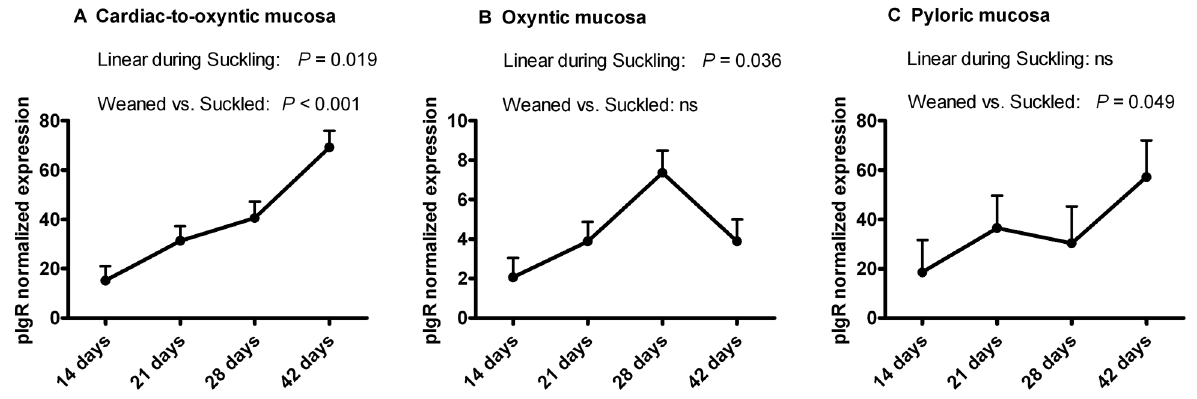
Figure 1. Polymeric immunoglobulin receptor (pIgR) mRNA expression in pig gastric mucosa. PIgR mRNA expression was determined in the mucosa at three gastric sites in piglets during the suckling period (14, 21 and 28 days of age) and after weaning (42 days of